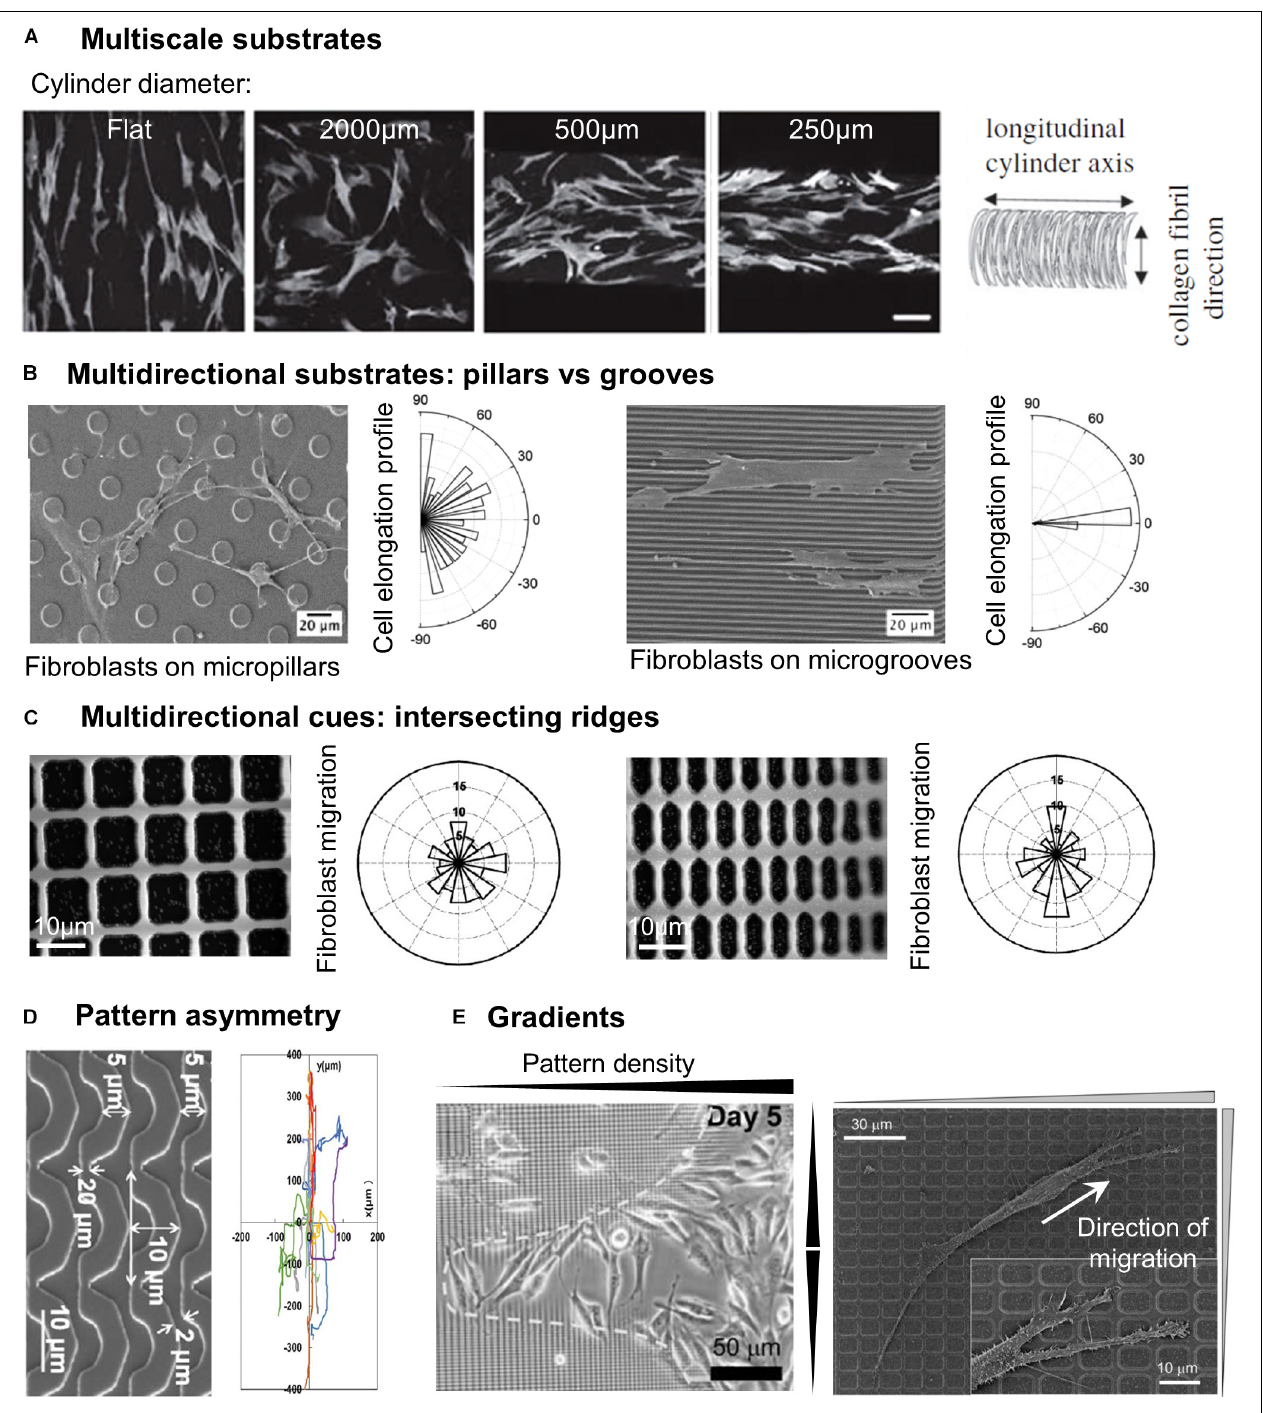
FIGURE 2 | Cell response to different categories of microstructured substrates. (A) Human bone marrow stromal cells stained by F-actin on cylinders of different curvatures coated with anisotropically aligned collagen nanofibrils. Scale 100 µ m. Reproduced with permission from Werner et al. (2018). (B) SEM images of fibroblasts on micropillars or microgrooves, associated with the cell elongation profile. Reprinted with permission from Ning et al. (2016). Copyright 2016 American Chemical Society. (C) Direction of fibroblast migration on a grid of intersecting ridges with different anisotropy. Reproduced with permission from Kim et al. (2009b). (D) Mouse osteoblastic cells migration tracks on substrates of arcs. Reproduced with permission from Tang et al. (2014). (E) Accumulation of fibroblasts in the center region of a gradient pattern with the highest density of structures (left). Close-up of a fibroblast migrating toward denser regions of the pattern (right). Reproduced with permission from Kim et al.